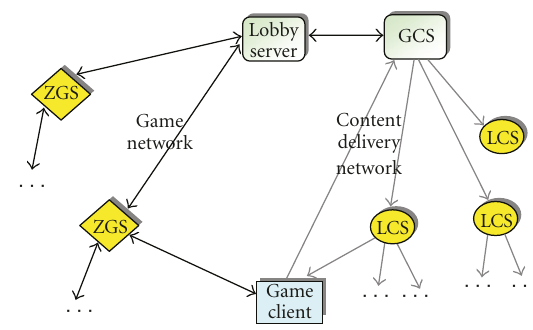
Figure 10: Overall network